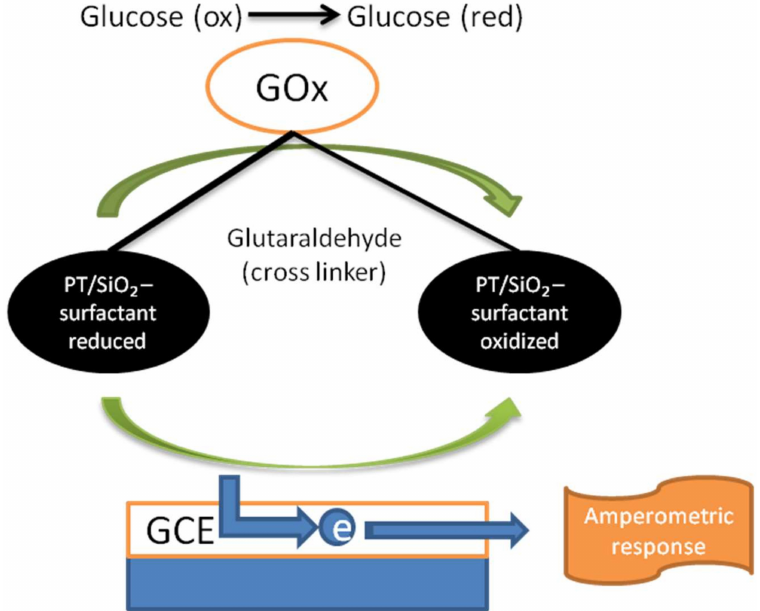
Figure 6. Representation of an amperometric glucose biosensor based on a polythiophene/SiO 2 nano-composite in the presence of surfactants